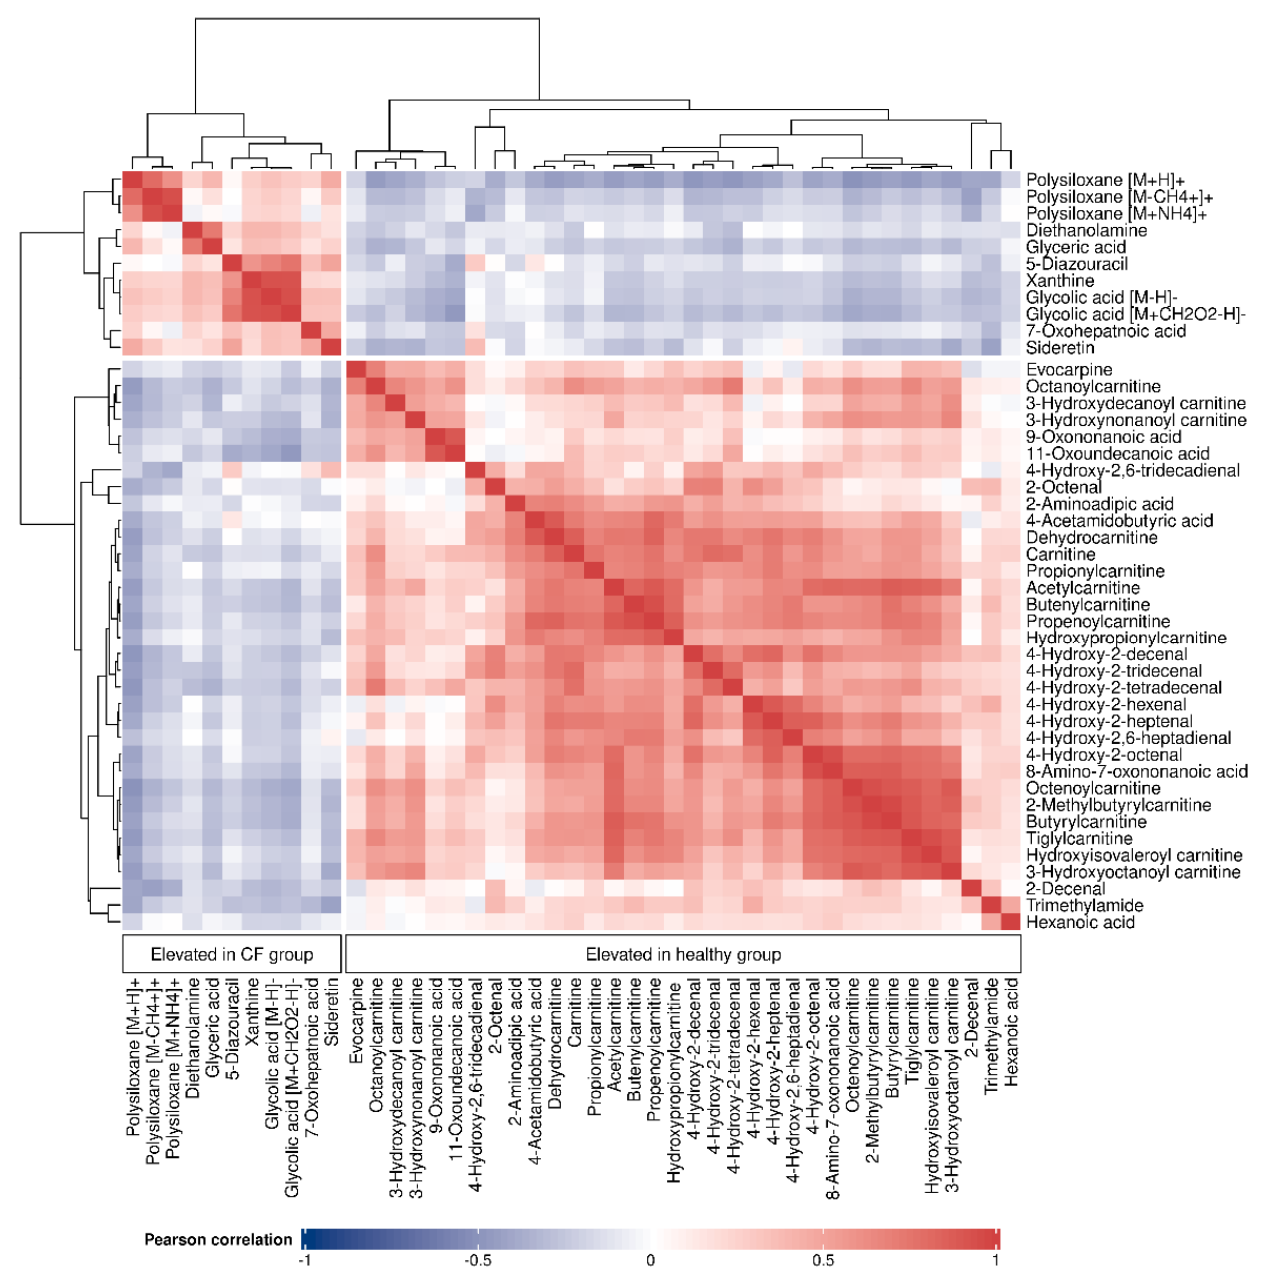
Figure 2. Correlation matrix heatmap of all the 45 identified compounds, with the dendrogram (right and top) depicting the relatedness among the compounds. Cell colors correspond to the Pearson correlation coefficients, ranging from blue (negative correlation) to red (positive correlation).